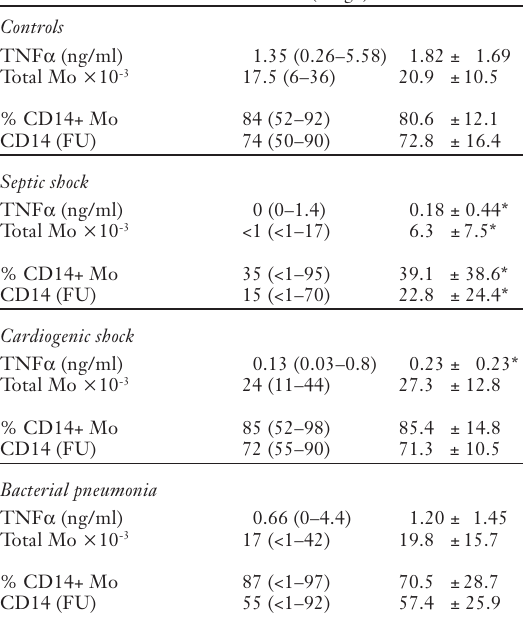
ΤΝ F α production and number of circulating monocytes, CD14+ monocytes, and CD14 expression in normal healthy vol- unteers (controls) and in patients with septic shock, cardio- genic shock or severe bacterial